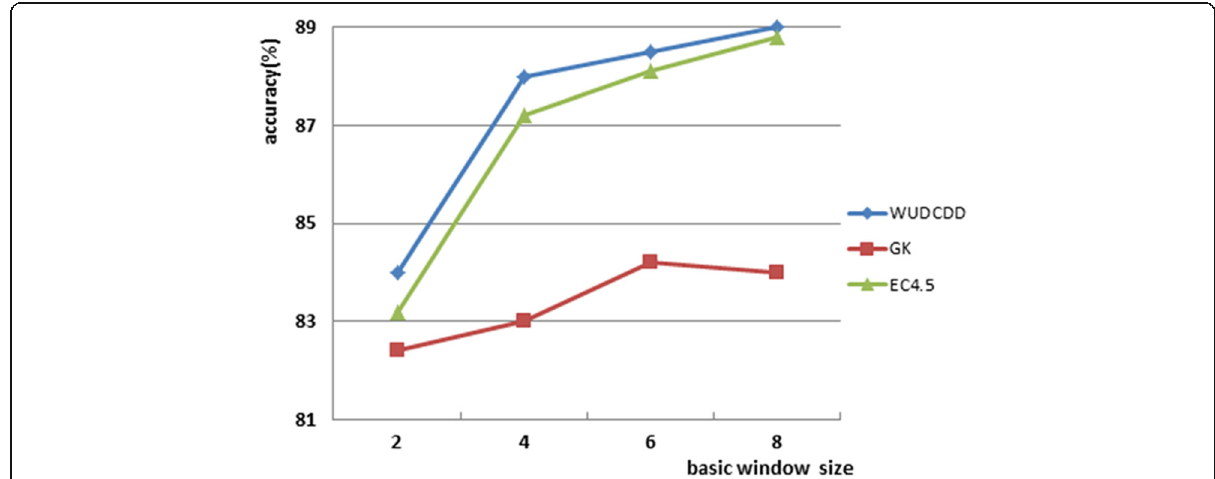
Fig. 2 Comparison of accuracy rates under different sliding windows